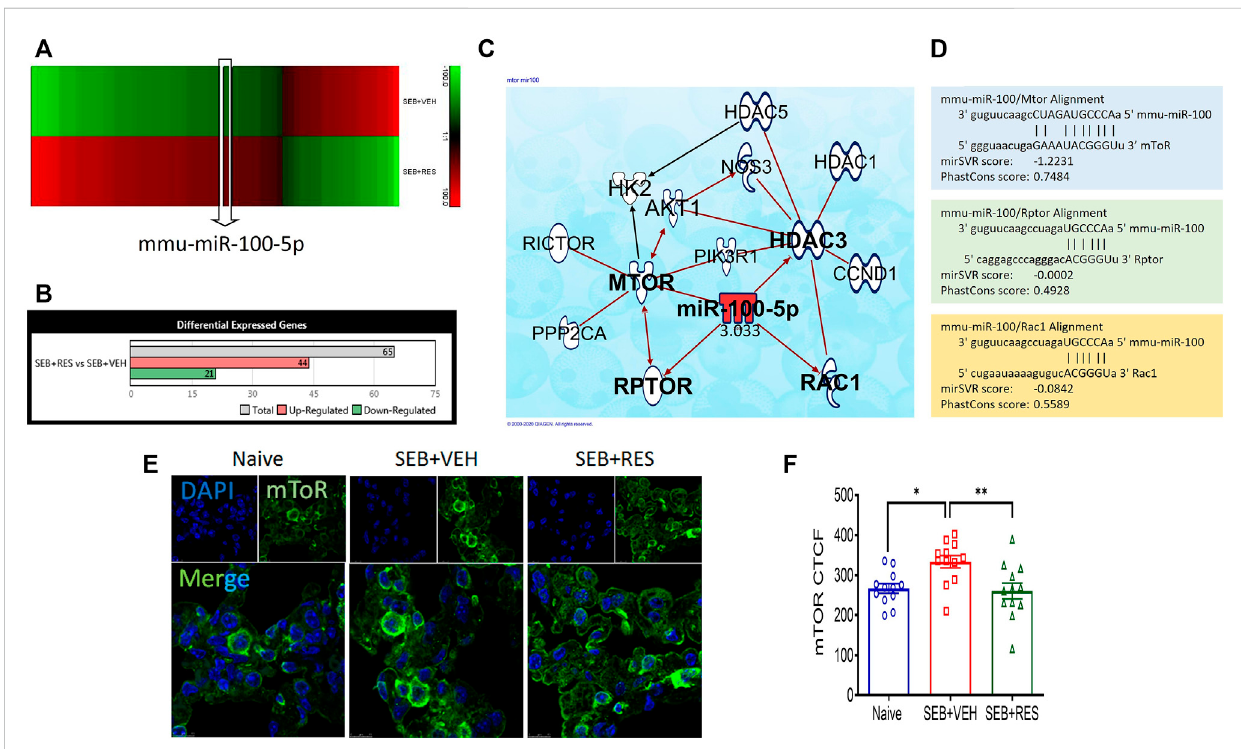
Effect of RES on miRNA induction and regulation of mTOR pathway in SEB-activated immune cells. Mice (n = 5) were exposed to SEB and treated with RES as described in Methods. Forty-eight hours later, mice were euthanized and studied as described below: (A) . Heat map showing altered expression of miRNAs in the lung mononuclear cells from SEB + VEH vs. SEB + RES groups. Five biological samples were pooled for the in silico analyses only,butallvalidationswereperformedonindividualsamples. (B) .BargraphdepictingcountsofdifferentiallyexpressedmiRNAswith2-foldchange. (C) .Ingenuitypathwayanalysis(IPA)predictedthetargetedgenesbymiR-100. (D) .SchemeofalignmentregionsbetweenmiR-100anditstargetedgenes (mTOR, Rptor and Rac1). (E) . Immuno fl uorescent staining showing mTOR protein expression in the lung sections imaged by Leica confocal microscope and quanti fi ed by ImageJ software. (F) . Statistical analysis of mTOR protein expression. Compared values represent mean ± standard error of means (M±SE). One-way ANOVA test with multiple Tukey ’ s correction was applied. p < 0.05 considered as signi fi cant threshold. Signi fi cant differences were depicted as * p < 0.05, ** p <